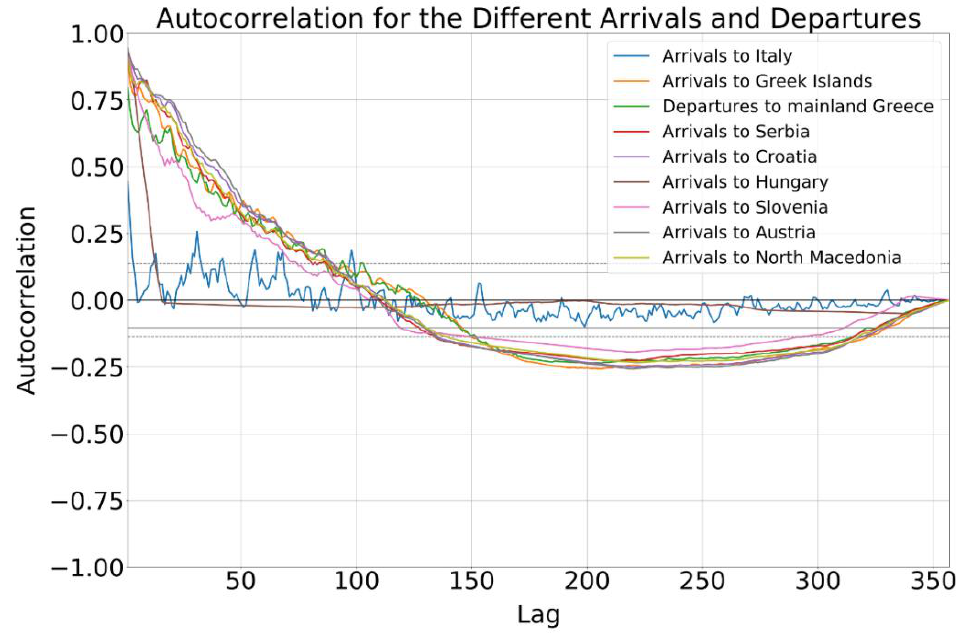
Figure 3. Autocorrelation plots for the different arrivals and departures indicating good autocorrelation functions at short lags (1–5 days).